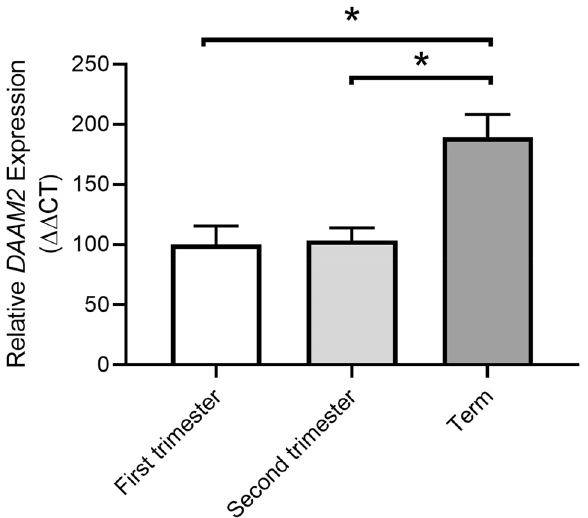
Figure 2. DAAM2 expression in placentas from first trimester, second trimester and term gestation. Expression of DAAM2 is significantly increased at term compared to first trimester and second trimester. There is no change in DAAM2 expression between first trimester and second trimester. Data presented as fold change from first trimester, mean ± SEM. *p < 0.05. First trimester; n = 6, 7–9 weeks. Second trimester; n = 4, 24–29 weeks. Term; n = 9; 38–39